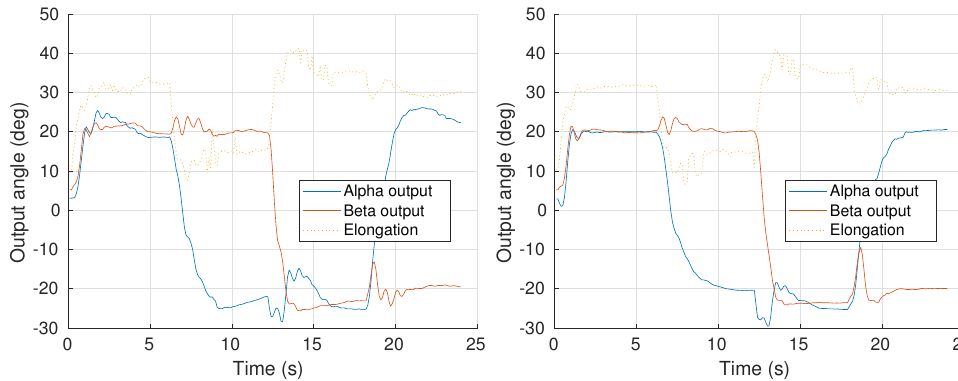
Figure 12. Experiment 3. Trajectory tracking. Time response for the two controllers tested, fractional ( left ) and integer ( right )